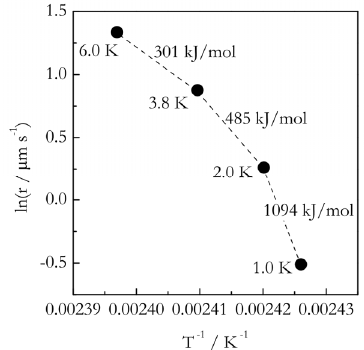
Figure 6. Arrhenius plot for the rate (r) of polyethylene melting (data from Czornyj and Wunderlich [75]). Numbers by the points represent the value of superheating at given temperature. Numbers by the dashed segments are estimates for the corresponding activation energies.